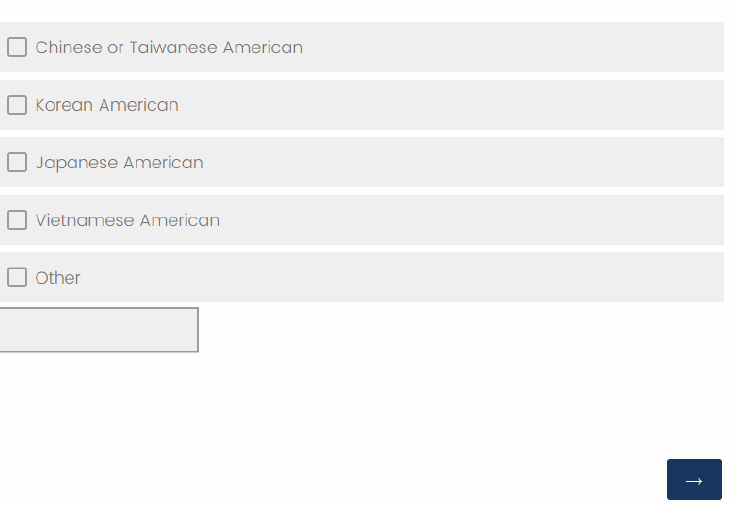
Figure 2. If “Extremely likely” or “likely” were selected for “Asian American”, listeners were given a follow-up question to further specify what kind of